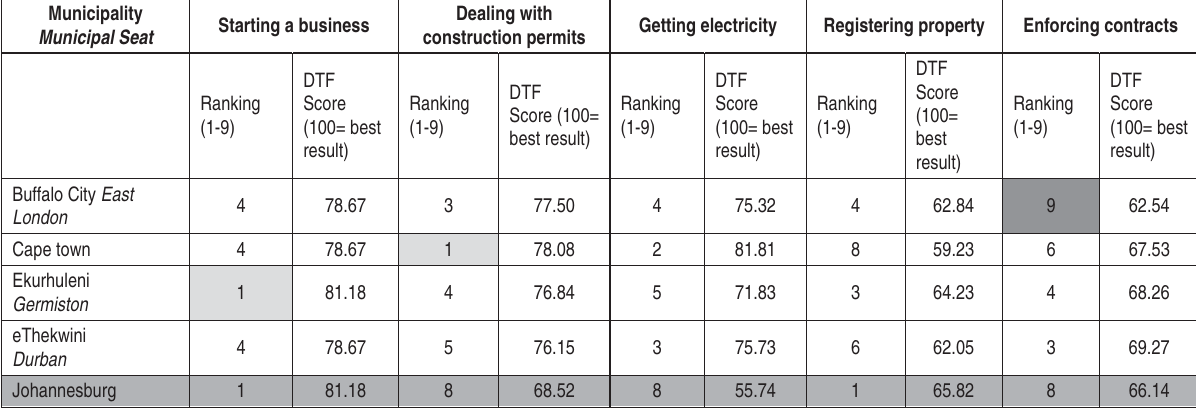
Table 1. Doing business in Johannesburg in comparison to other South African metros Municipality Municipal